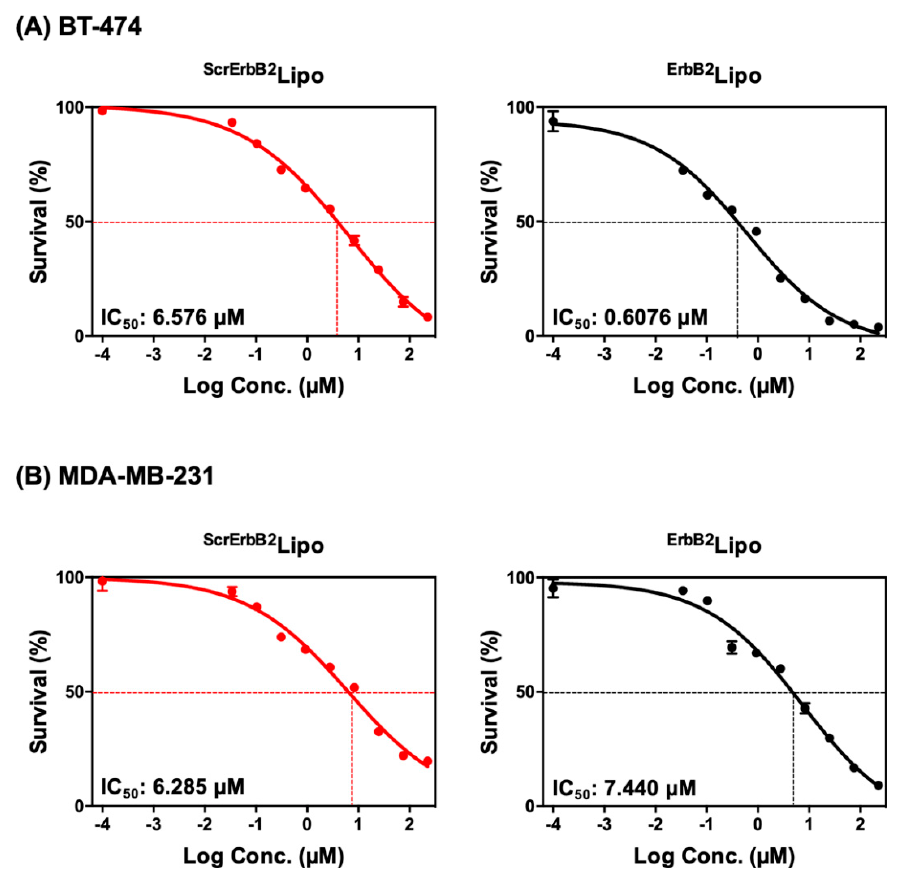
Figure 6. The cytotoxicity of ScrErbB2 Lipo and ErbB2 Lipo after 72 h in ( A ) BT-474 and ( B ) MDA-MB-231 cells. Results are presented as mean ± SEM (n = 8).